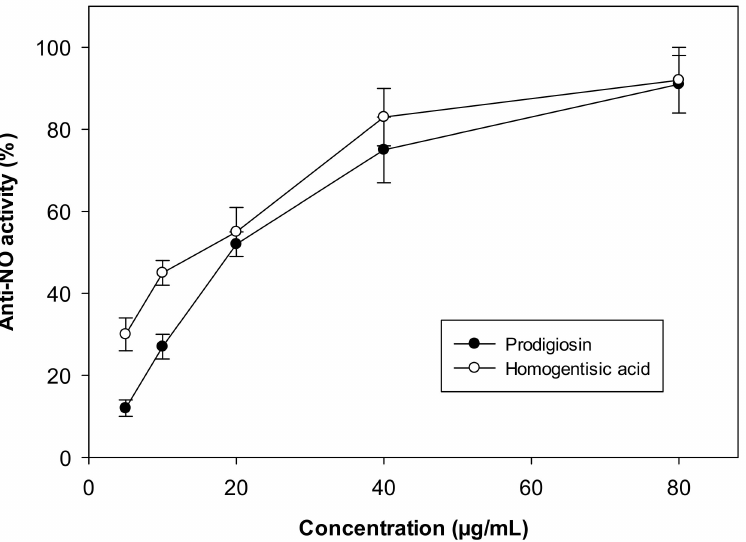
Figure 5. The anti-NO activity of prodigiosin (PG) produced via fermentation in this study. The error bars in the figures are standard errors